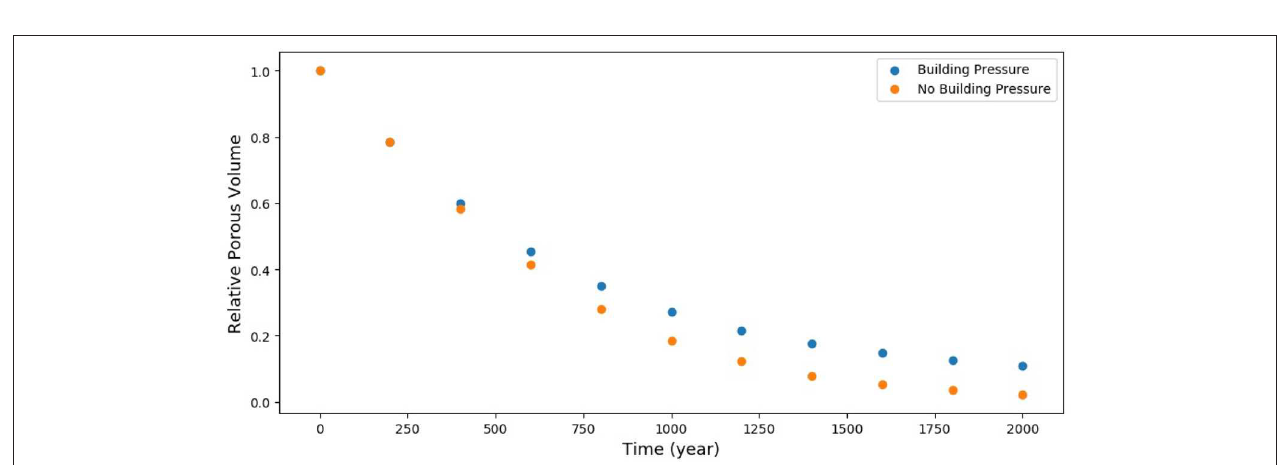
FIGURE 7 | Relative volume as a function of time, with or without building of internal pressure.